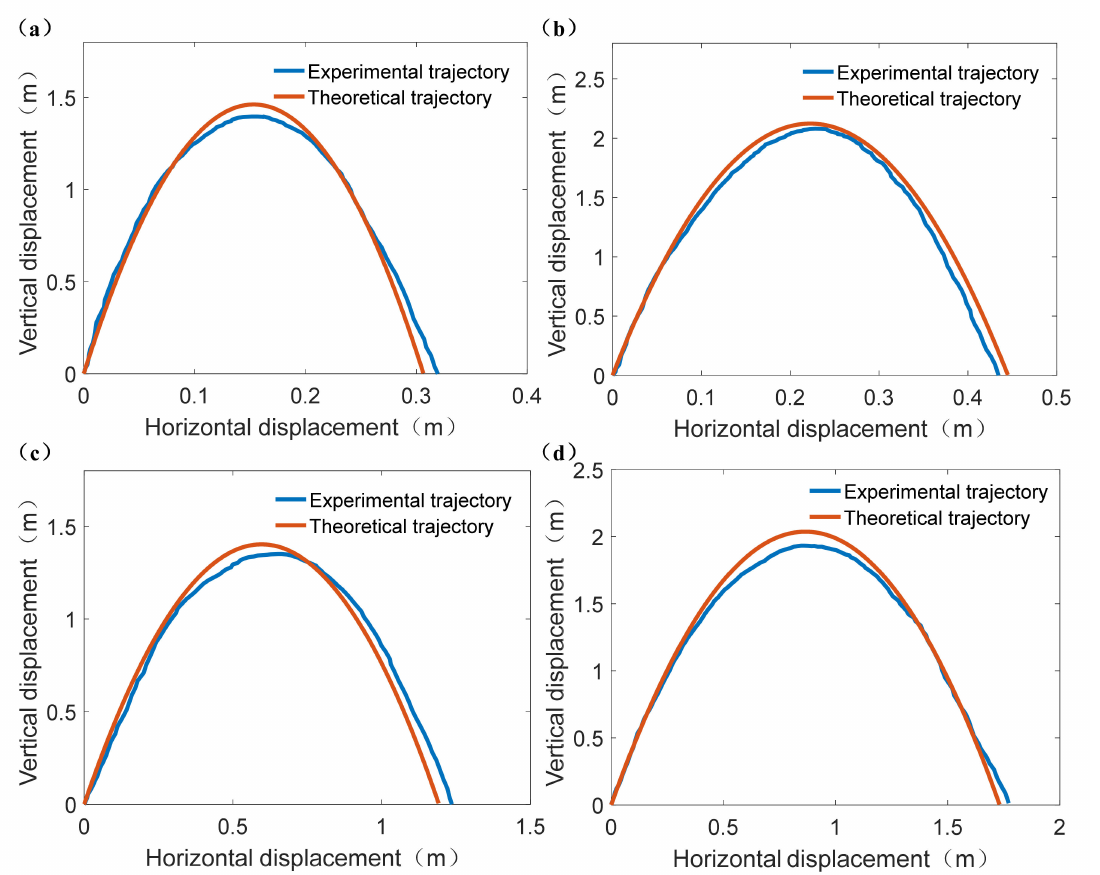
Figure 11. The comparisons of experimental jumping trajectories and theoretical jumping trajectories under different take-off parameters. ( a ) ϕ 0 = 87 ◦ , P max = 1.81 MPa. ( b ) ϕ 0 = 87 ◦ , P max = 2.23 MPa. ( c ) ϕ 0 = 78 ◦ , P max = 1.81 MPa. ( d ) ϕ 0 = 78 ◦ , P max = 2.23